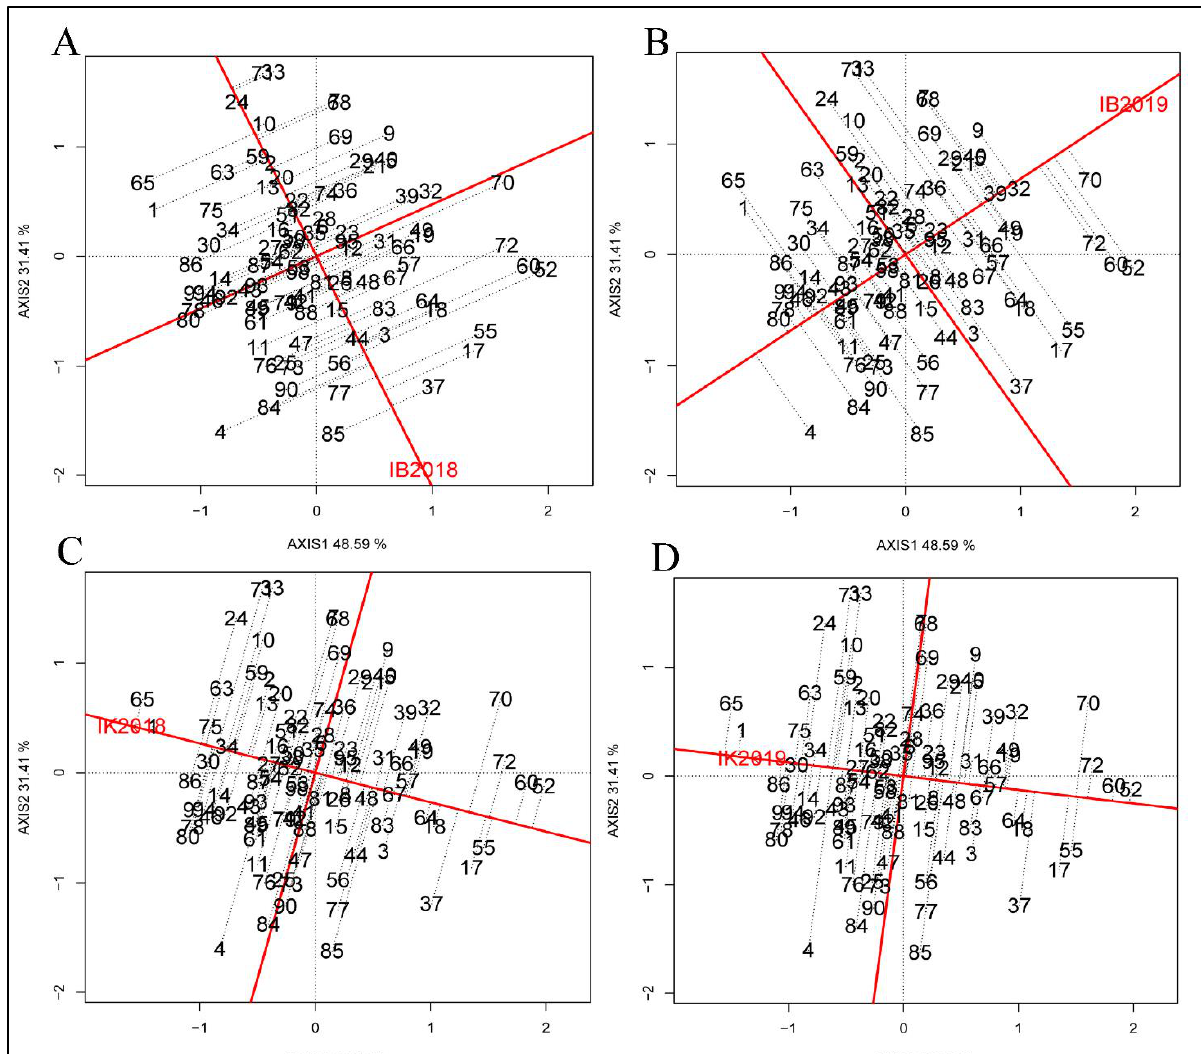
Figure 3. Evaluation of the performances of accessions in the tested environments: ( A ) Ibadan 2018, ( B ) Ibadan 2019, ( C ) Ikenne 2018, and ( D ) Ikenne 2019.